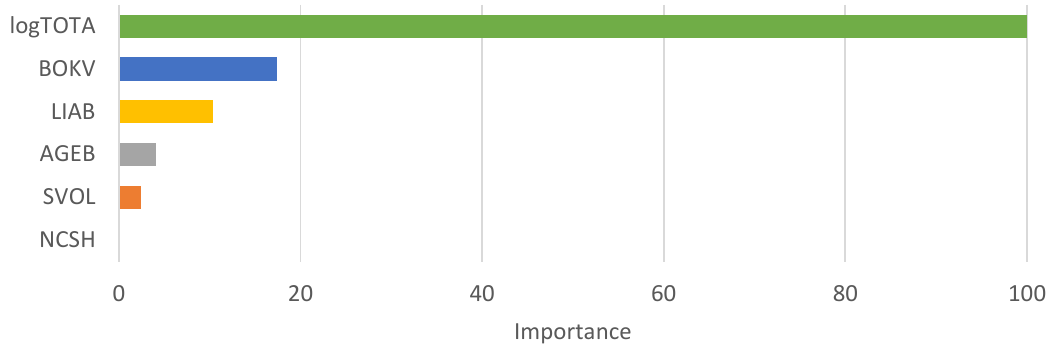
Figure 8. Conditional inference tree variable importance scores for EPS